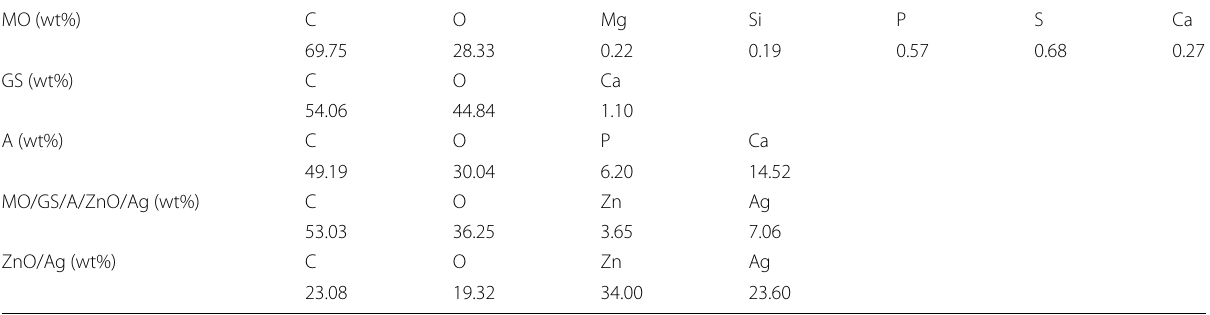
Table 3 The elemental composition of the various biomasses used in the synthesis of photocatalysts as determined by EDS analysis MO (wt%)